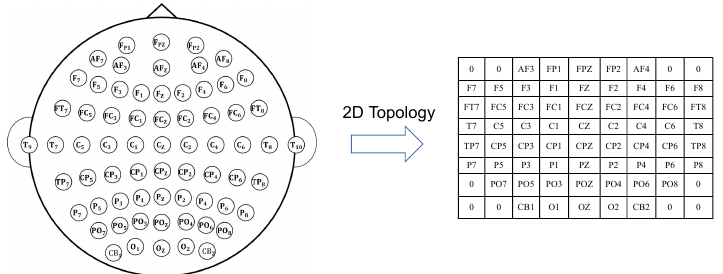
Figure 2. Two-dimensional coordinates of the 62 EEG channels. We project the 62 electrodes of the EEG into 2D. The positions of channels are shown on the left and resized into an 8 × 9